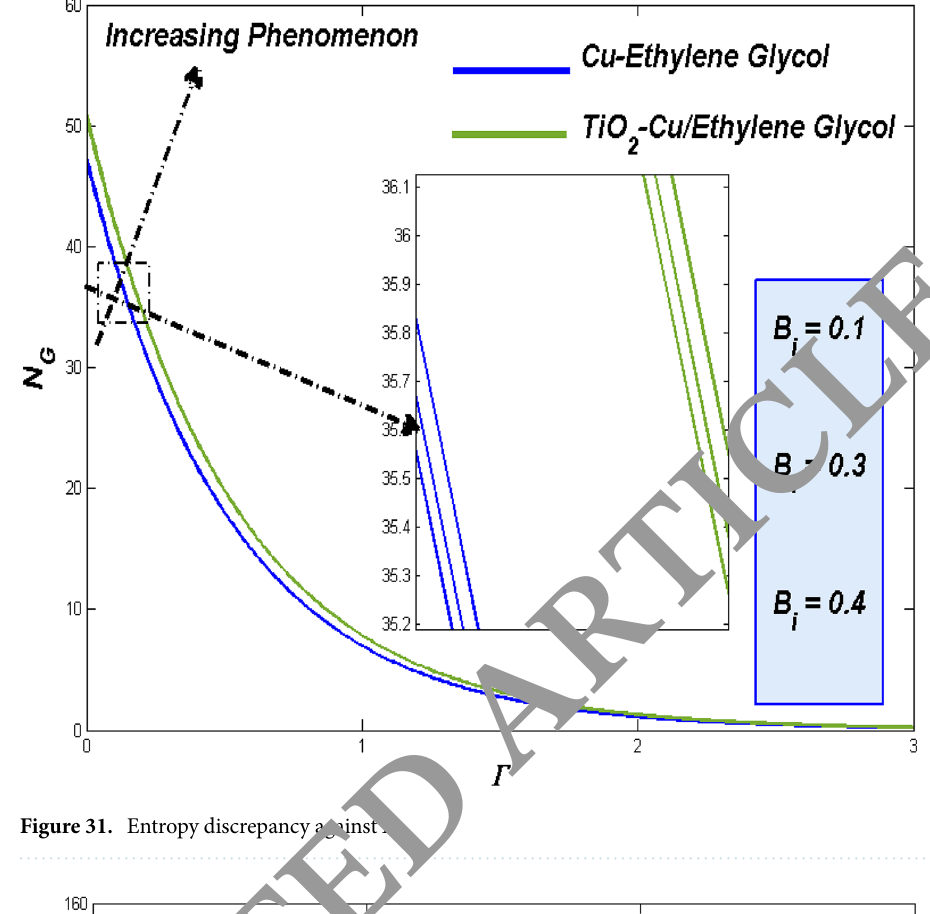
Figure 31. Entropy discrepancy against B i .